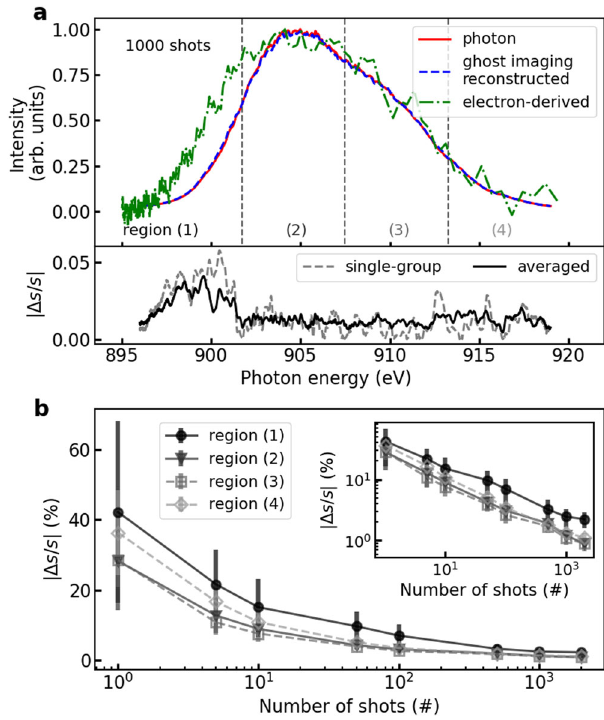
Fig. 7 Averaged ghost-imaging-reconstructed versus averaged photon spectra. a Upper panel shows the averaged spectrum for a group of 1000 shots for photon (red solid line), ghost-imaging reconstructed (blue dashed line), and electron-derived, i.e., without application of ghost- imaging (green dot-dashed line). Note the electron-derived spectrum fails to reproduce the averaged photon spectrum in contrast to the ghost- imaging reconstruction. The spectrum is divided into regions 1 – 4, going from low to high photon energies. The lower panel shows the corresponding spectral percentage deviation between the ghost-imaging reconstructed and true photon spectra for a single 1000-shot group (dashed) and averaged over seven 1000-shot groups (solid). b The normalized deviation Δ s / s (Eqn. (4)) for each spectral region 1 – 4 as a function of the number of averaged shots. The error bars represent the standard deviation of Δ s / s